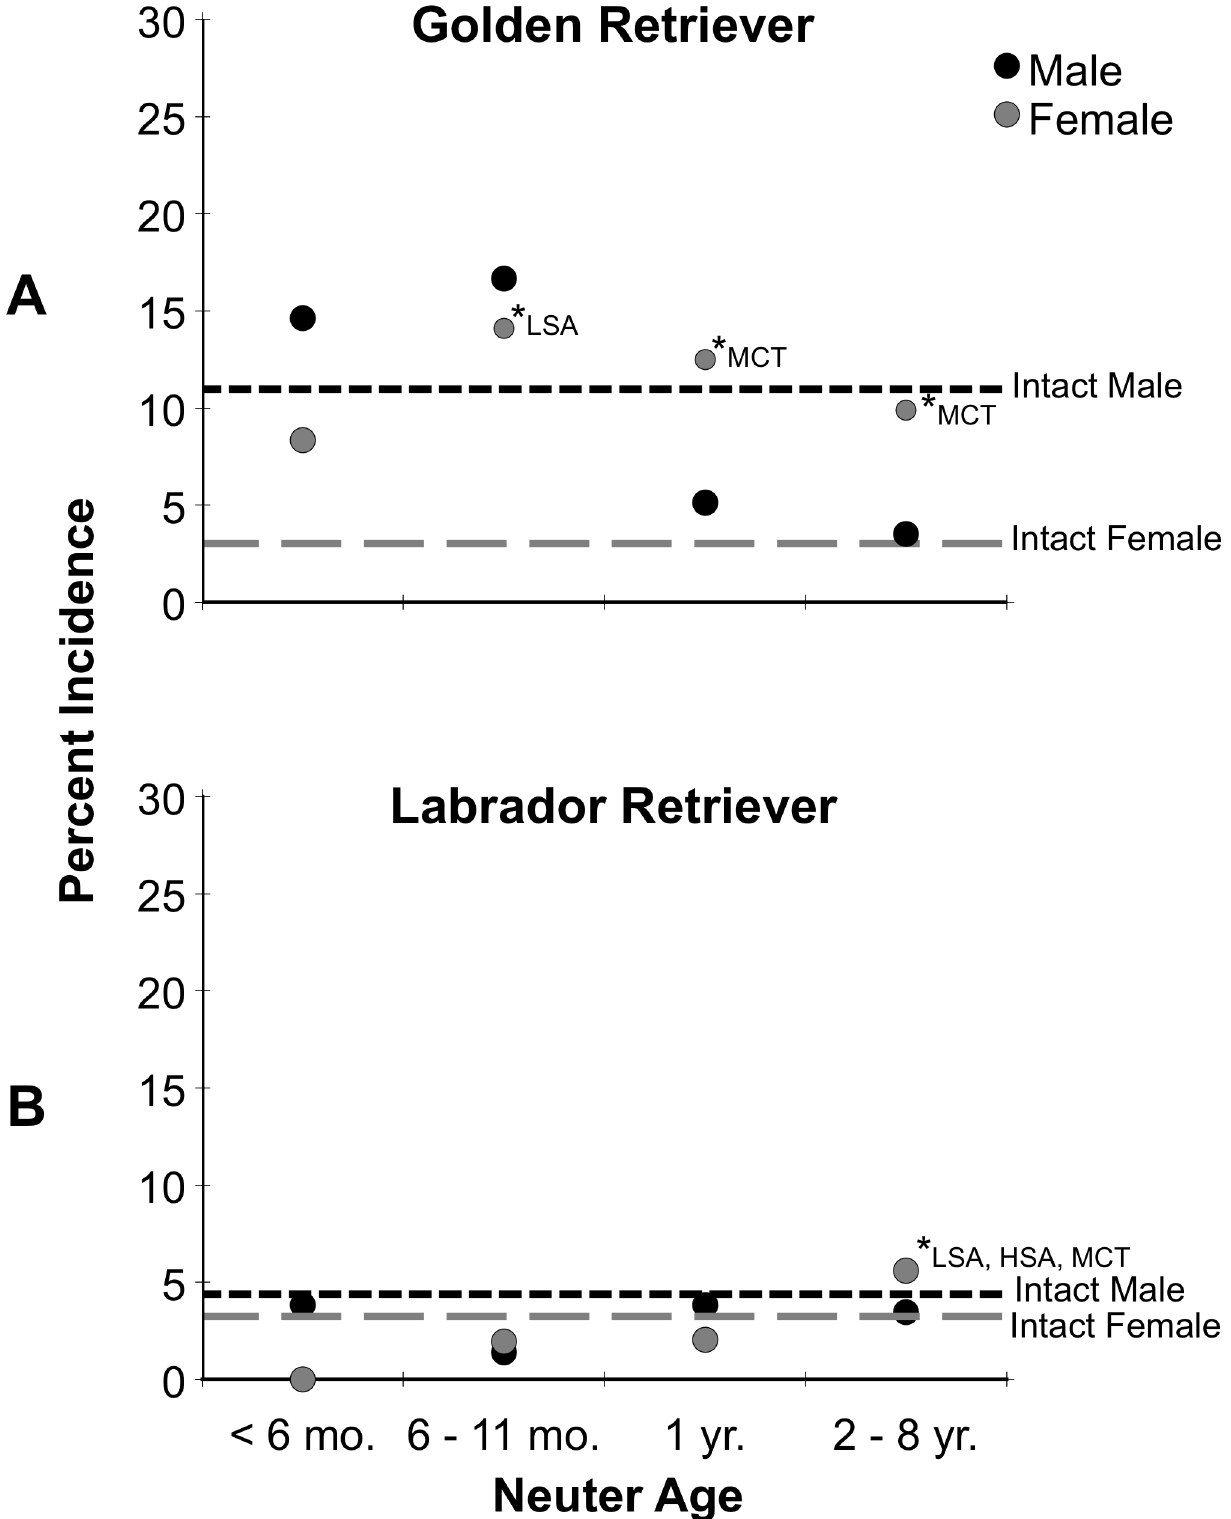
Figure 2. Incidence of the occurrence of at least one cancer in male and female Golden Retrievers (top) and Labrador Retrievers (bottom), as a function of age at neutering. The occurrences in intact males and females for the same measures are shown by the horizontal lines. The asterisks indicate significance from the intact level, and the abbreviations reveal the cancers contributing to the dots when significant.